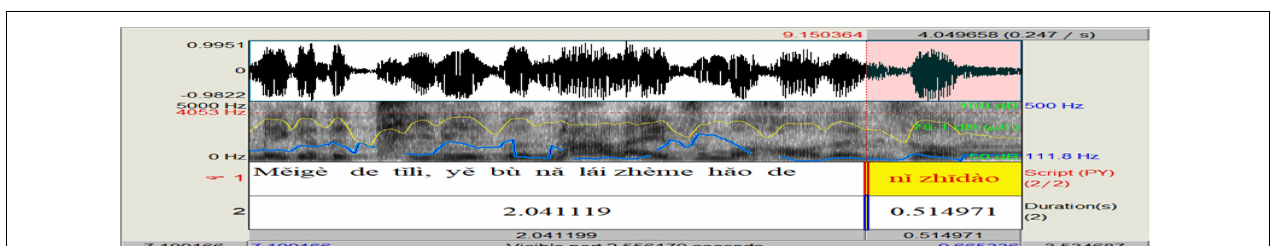
FIGURE 9 | Praat analysis of between-clause ni zhidao.